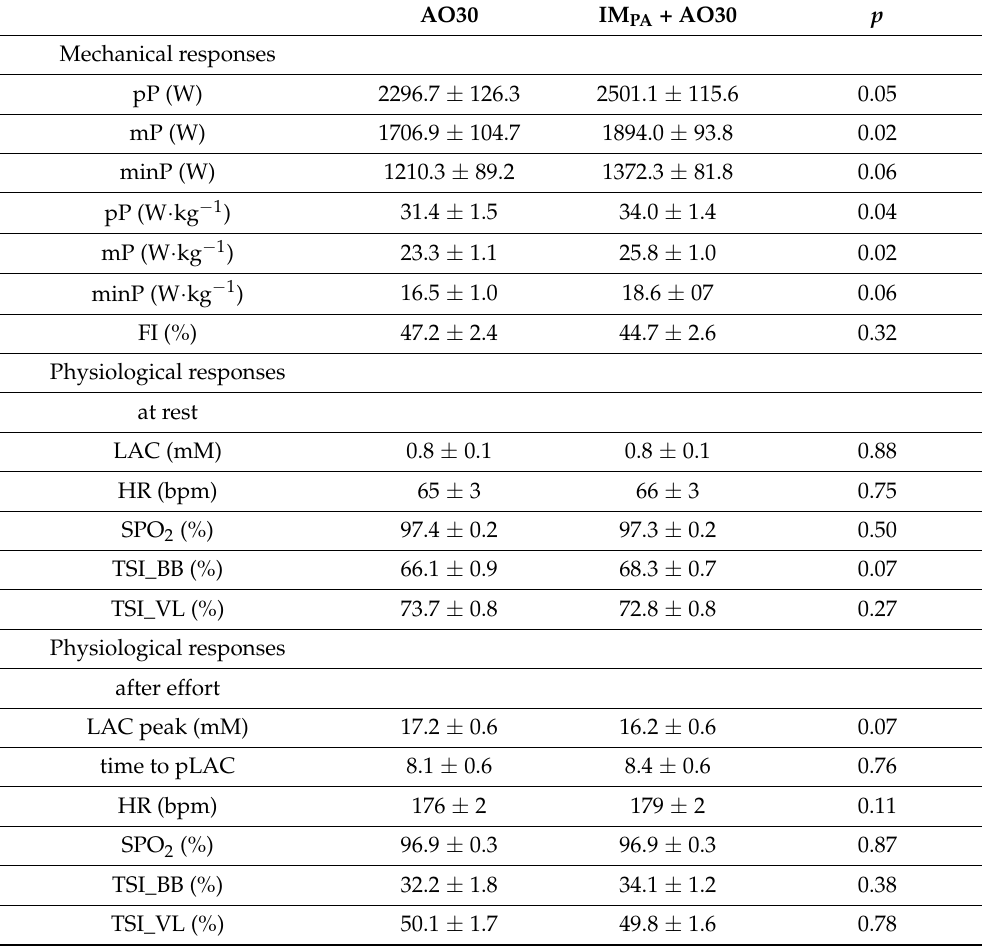
Table 1. Peak, mean and minimum values of the absolute running power (W) and the power relative to body mass (W · kg − 1 ) during the AO30 exercise ( n = 15) and AO30 with inspiratory muscle pre-activation (IM PA + AO30), and physiological responses at rest and after effort in these two experimental sessions. AO30 IM PA + AO30 p Mechanical